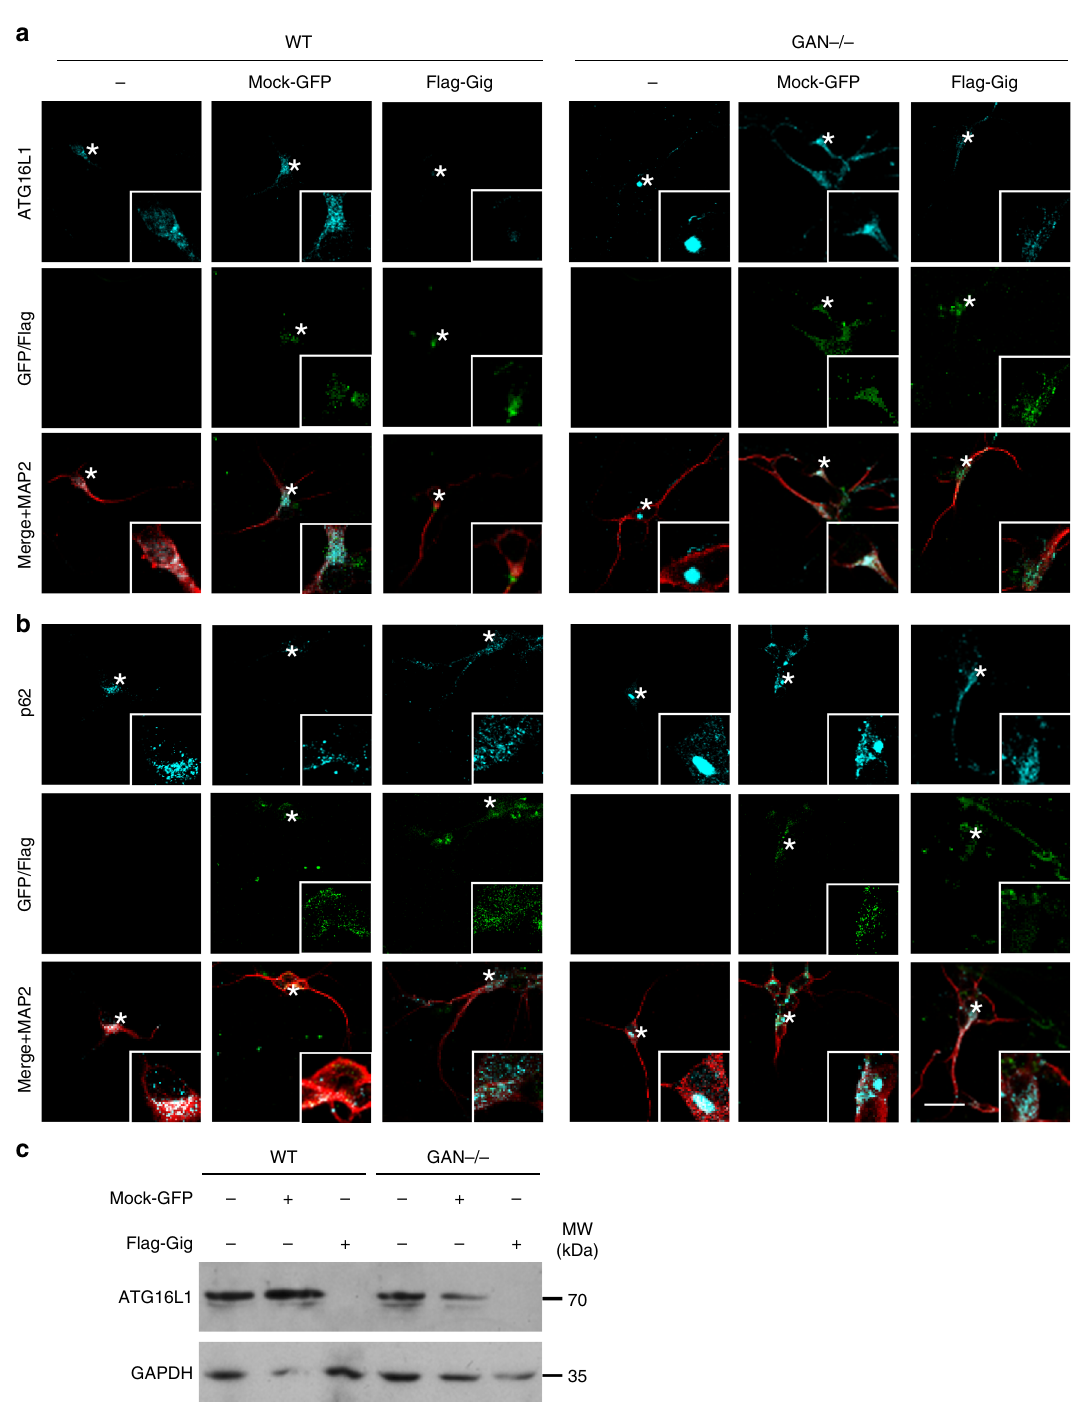
Fig. 6 Early and late autophagy steps are rescued by lentiviral-Gigaxonin in GAN -/- neurons. Immunostaining ( a ) and immunoblots ( c ) for ATG16L1 were performed on 4 div control and mutant neurons, after transduction with mock-GFP or Flag-Gigaxonin lentivirus. Both normal and bundled ATG16L1 were cleared upon expression of Gigaxonin in control and GAN -/- neurons, respectively. b Gigaxonin expression restored p62 levels in mutant cells, supporting an effective maturation of autophagosomes and autophagy degradation. Scale bar: 20 µ